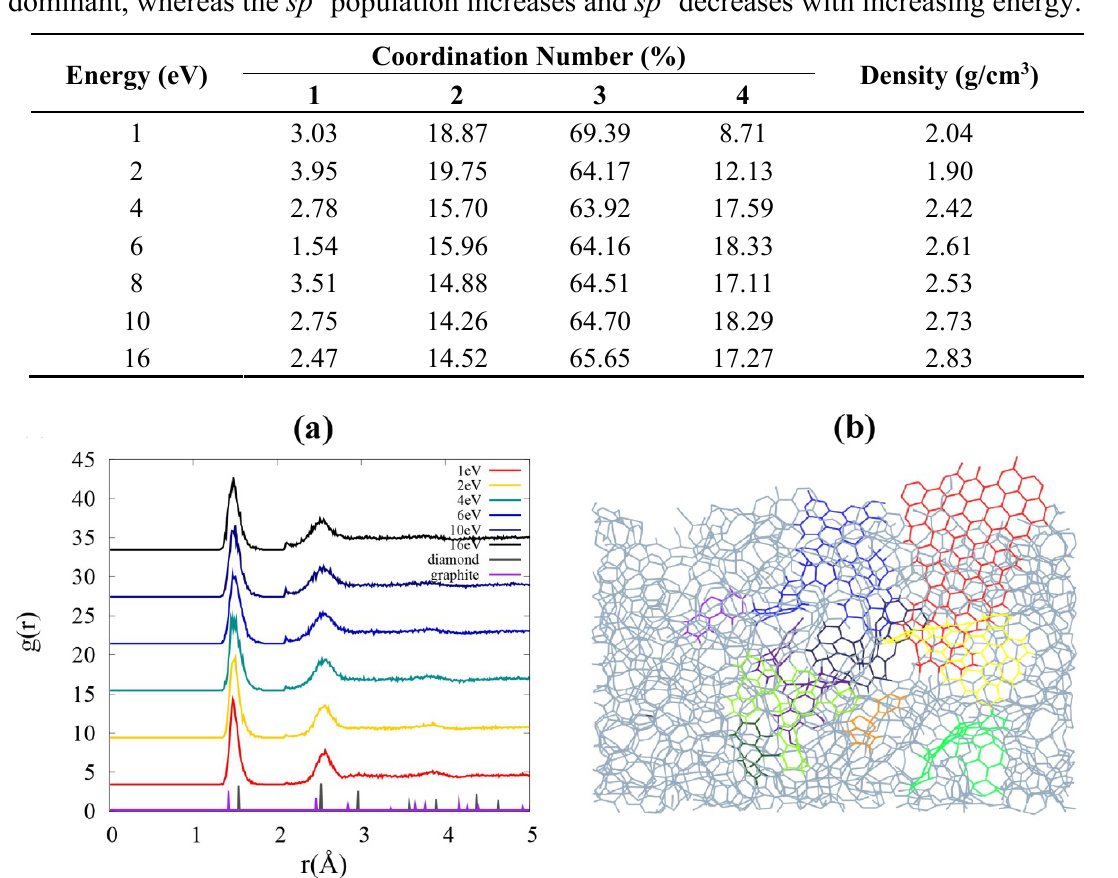
Figure 1. ( a ) Radial distribution functions (RDF) g( r ) of the films with different incident energies. Two broadened peaks at higher energies imply the formation of sp 3 -hybridized carbons. ( b ) A sliced image of the film grown with incident energy of 1 eV. Basic structural units (BSUs), the graphene flakes, are embedded in the film. Flakes of different color codes are connected to each other by sp 1 chains, sp 3 intersections, or